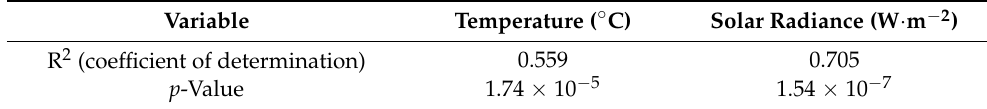
Table 6. Model summary of IoU vs. temperature and solar radiance.